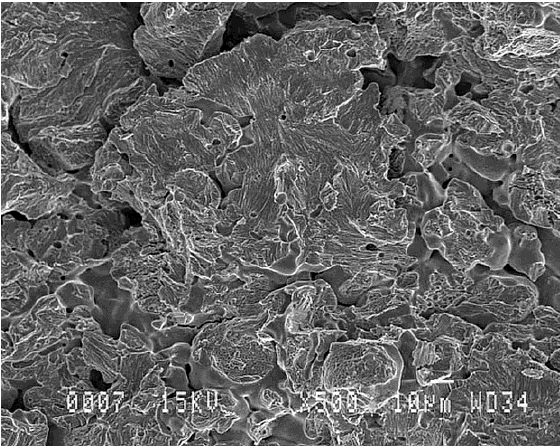
Figure 11. Fracture surface of the admixed PM steel at R = 0.7. The grains have been cut by the crack showing the transgranular fracture in some parts of the fracture surface.